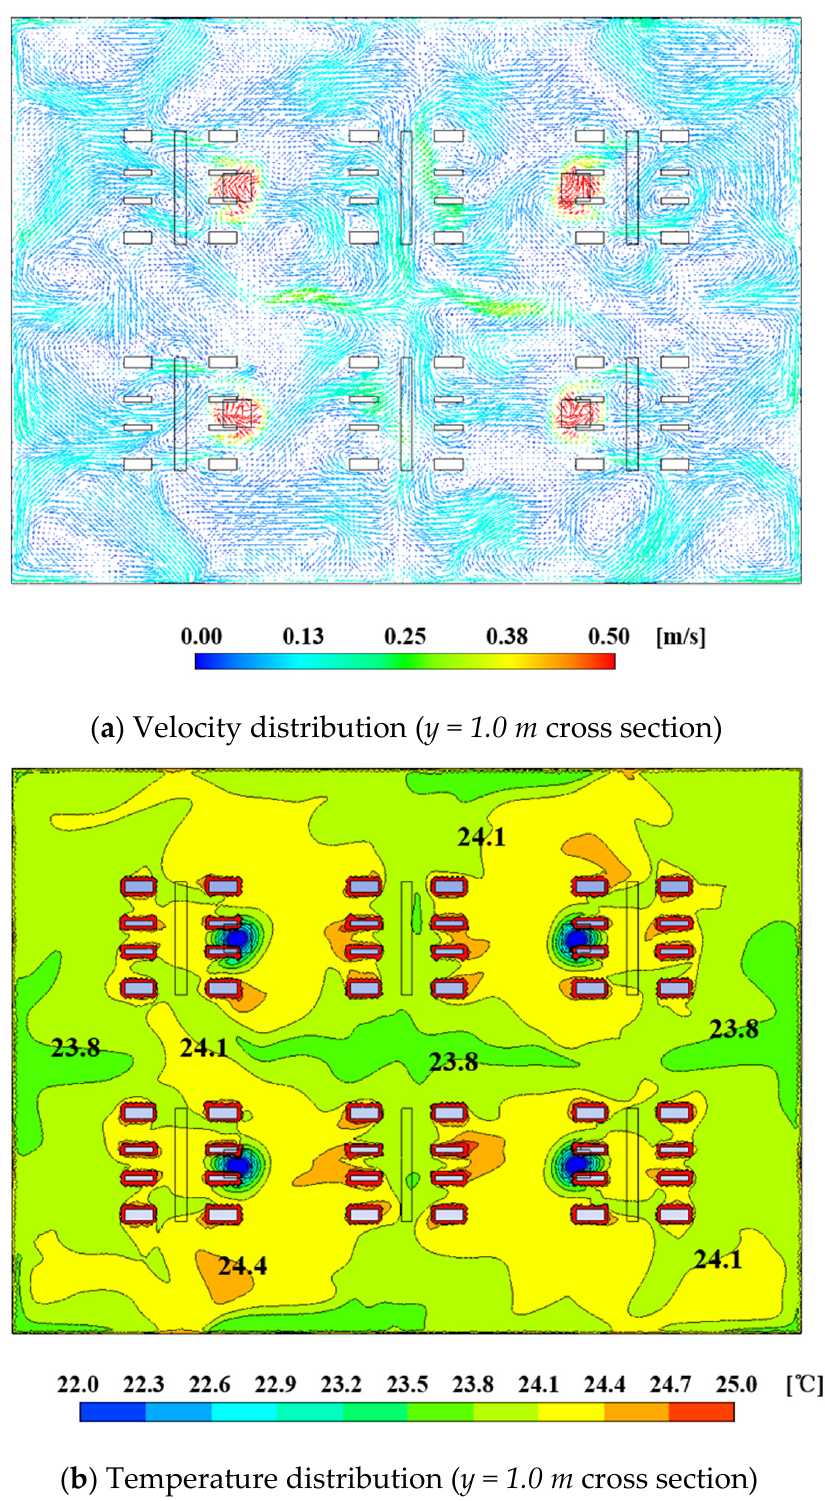
Figure 5. Velocity and temperature distributions ( y = 1.0 m cross section).